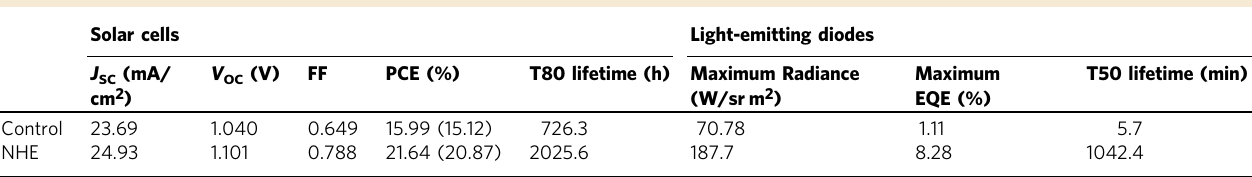
Table 1 Measured performance parameters of perovskite solar cells and light-emitting diodes based on the control and NHE fi lms.